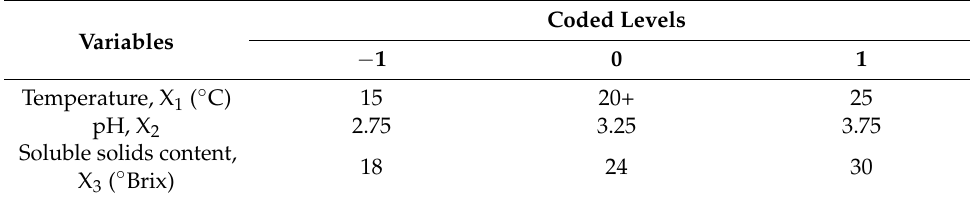
Table 1. Independent variables in the experimental